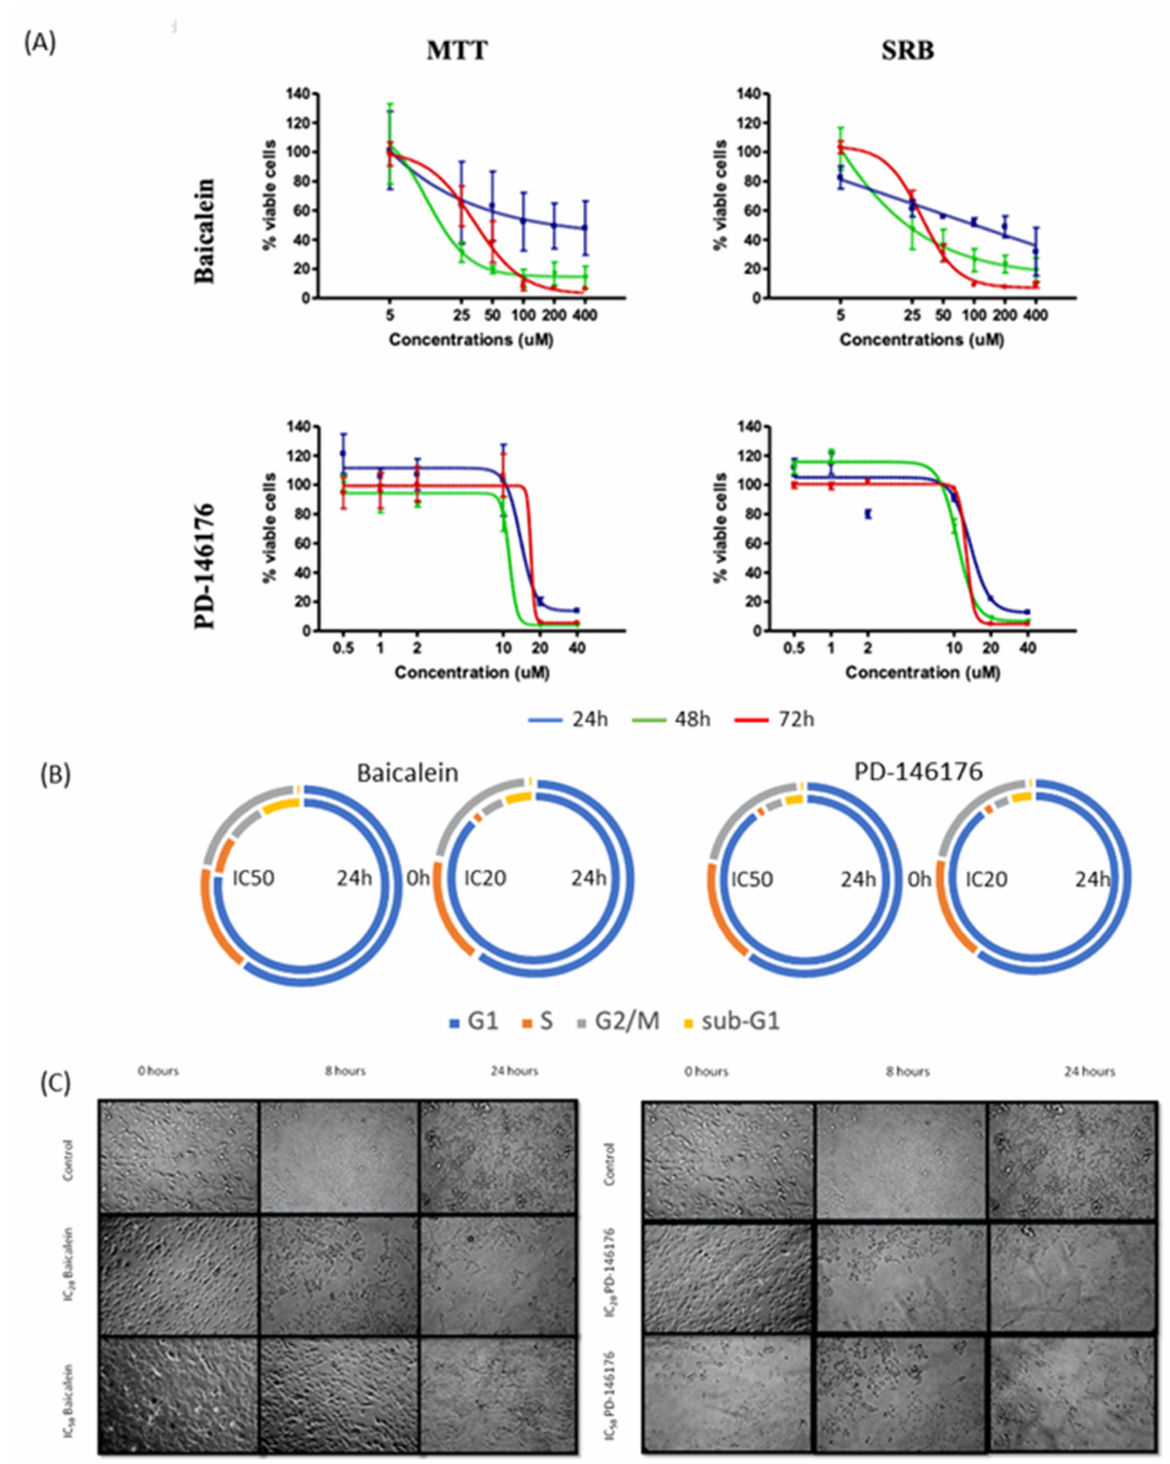
Figure 8. Effects of baicalein and PD-146176 on proliferation, mitochondrial viability, and morphology of B16F10 cells. ( A ) Mitochondrial viability (MTT) and antiproliferative (SRB). ( B ) Cell cycle distribution (%) after 24 h incubation with IC 20 and IC 50 of the inhibitors. ( C ) Cell morphology of treated cells. Values are the mean of three independent